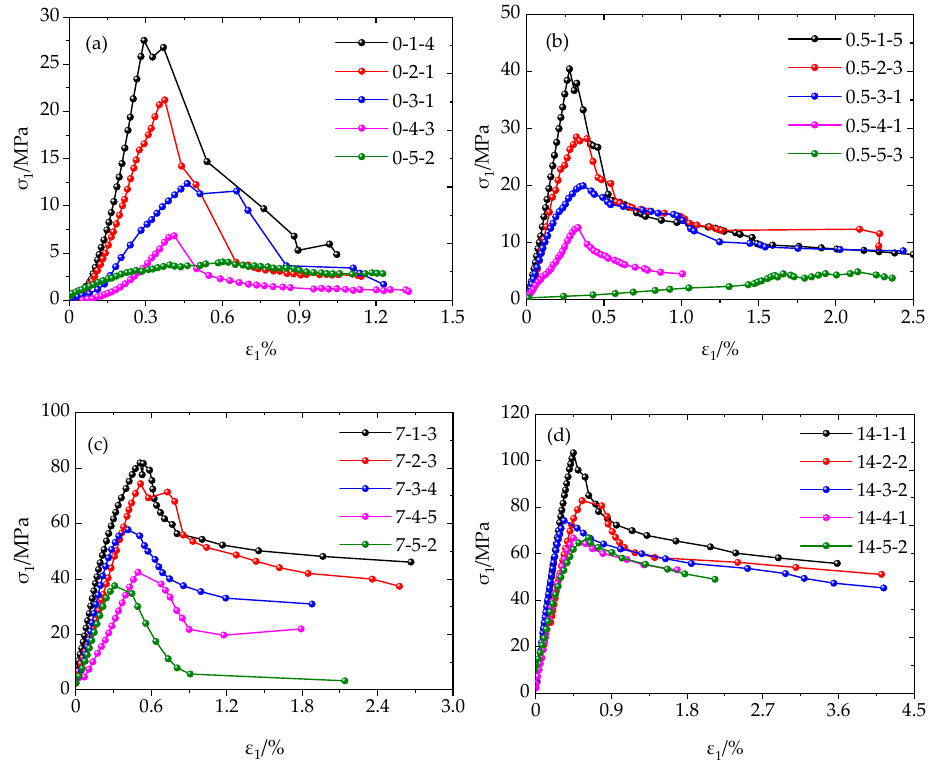
Figure 5. Stress–strain curves of the mudstone under different confining pressures and water contents: ( a ) confining pressure of 0 MPa; ( b ) confining pressure of 0.5 MPa; ( c ) confining pressure of 7 MPa; and ( d ) confining pressure of 14 MPa.